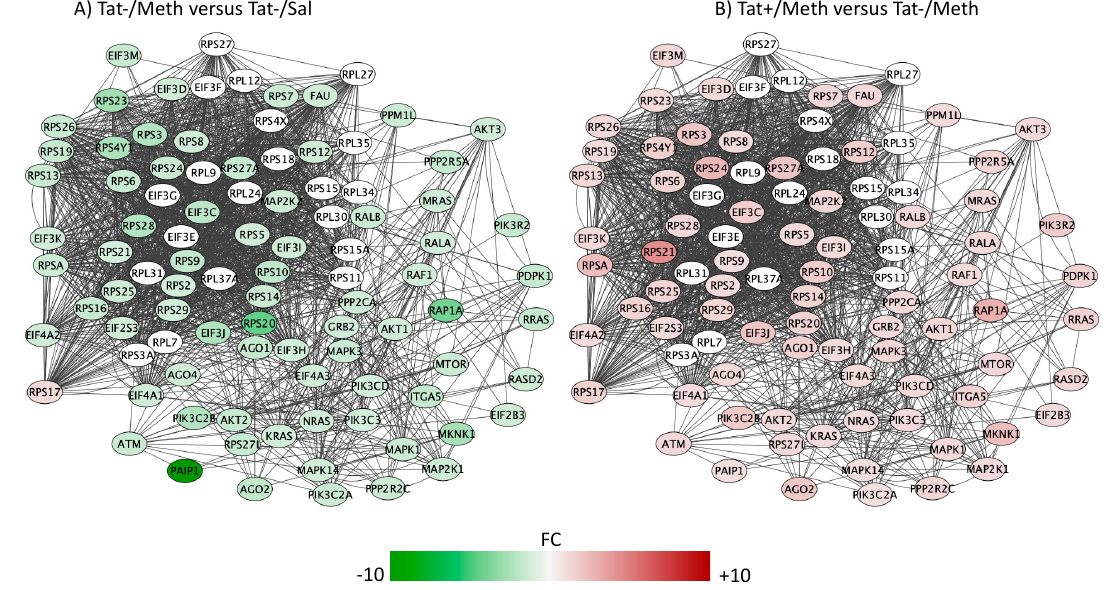
Figure 8. Regulation of the eukaryotic initiation factor 4 (eIF4) and p70S6K signaling. Genes with overlapping actions observed in ( A ) Tat − / Meth vs. Tat − / Sal and in ( B ) Tat +/ Meth vs. Tat − / Meth, and assigned to the regulation of eIF4 and p70S6K signaling were loaded into Cytoscape via Genemania; significant changes associated to assigned comparisons ( p < 0.01) were visualized by loading the node attributes table. Tat − / Meth vs. Tat − / Sal p = 7.55 × 10 − 6 and Tat +/ Meth vs. Tat − / Meth p = 7.53 × 10 − 6 , with 51.8% and 48.9% overlap, respectively.